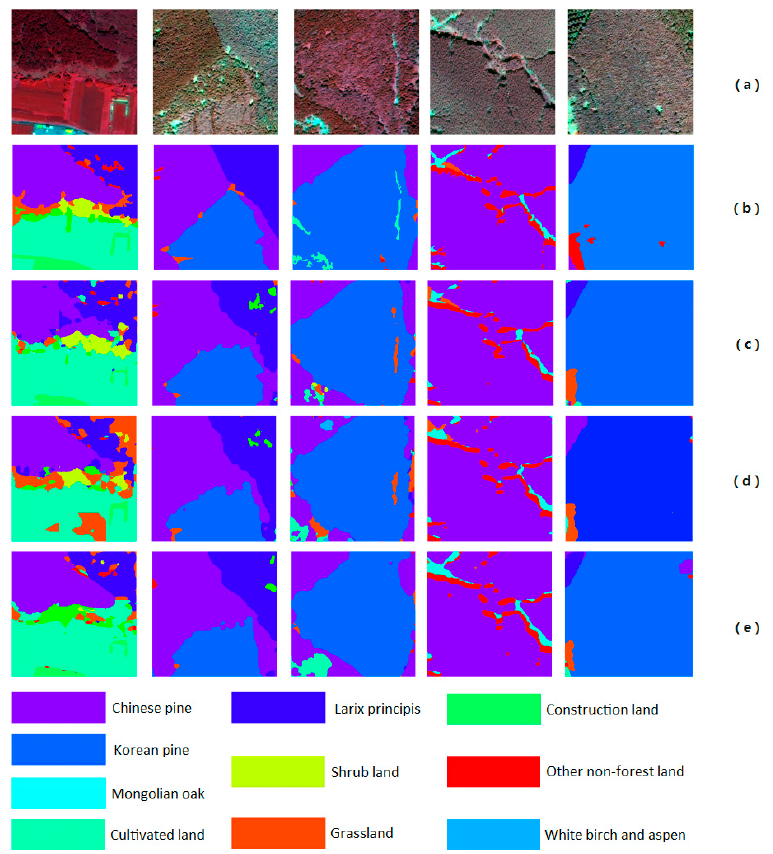
Figure 10. The detailed information of without and with convolution module and residual convo- lutional module into the skip connection ( a ) GF-2; ( b ) label; ( c ) dual-uNet-Resnet; ( d ) dual-uNet- Resnet-ConvConnect; ( e ) dual-uNet-Resnet-WithoutConnect.